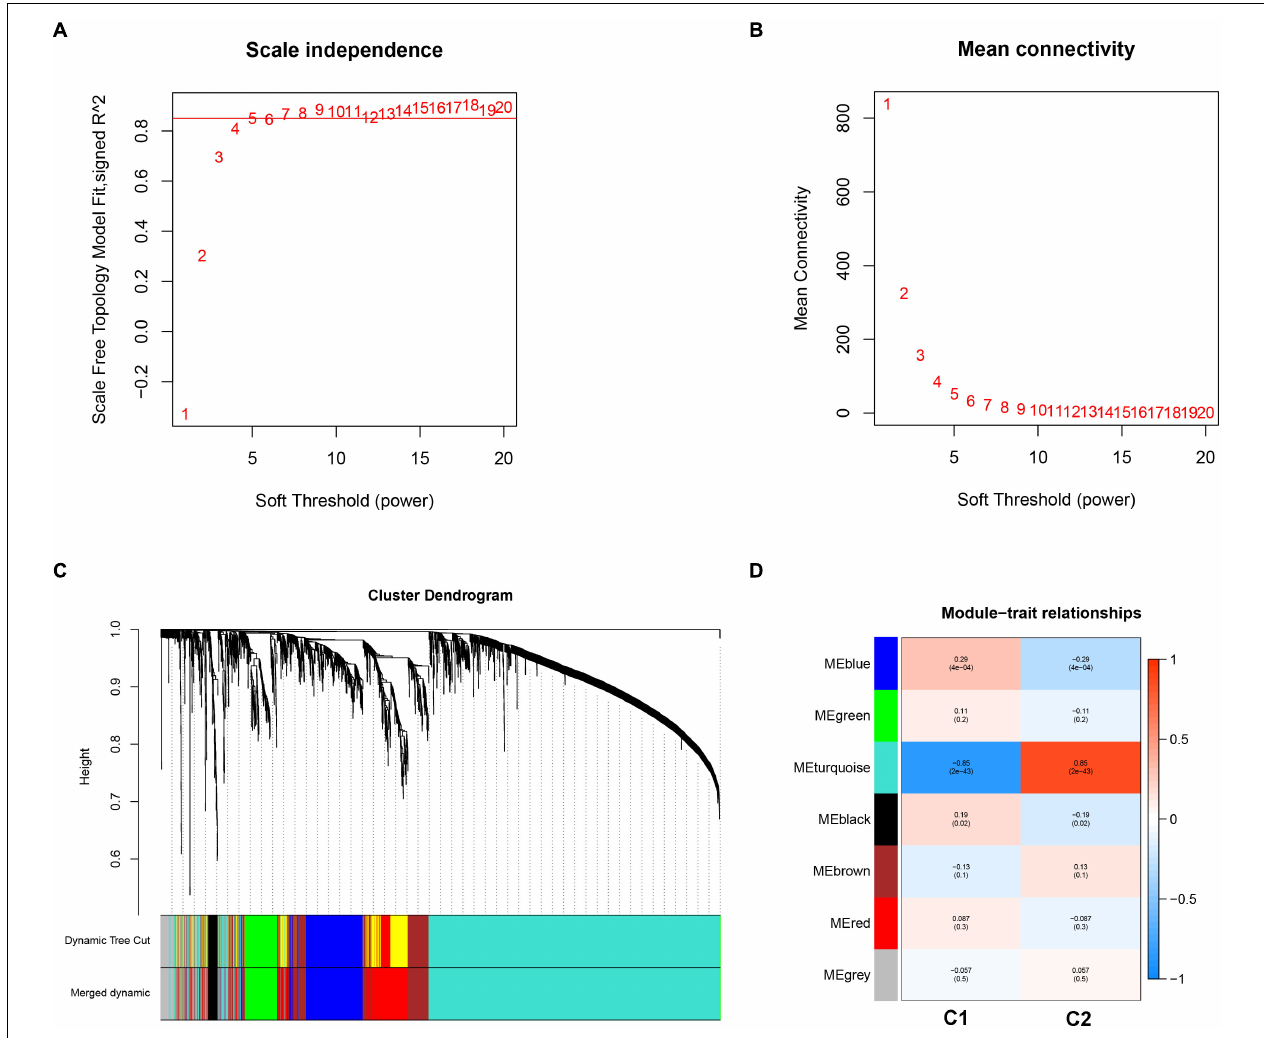
FIGURE 5 | Key modules identification of the two subgroups using weighted correlation network analysis. (A) Scale-free fitting index analysis for different soft-thresholding forces ( β ). (B) Mean connectivity for different soft-thresholding powers. (C) Clustering dendrograms for the top 25% variance genes on the basis of dissimilarity topological overlap and module colors. (D) Module-trait heatmap was constructed by using the correlation coefficient.